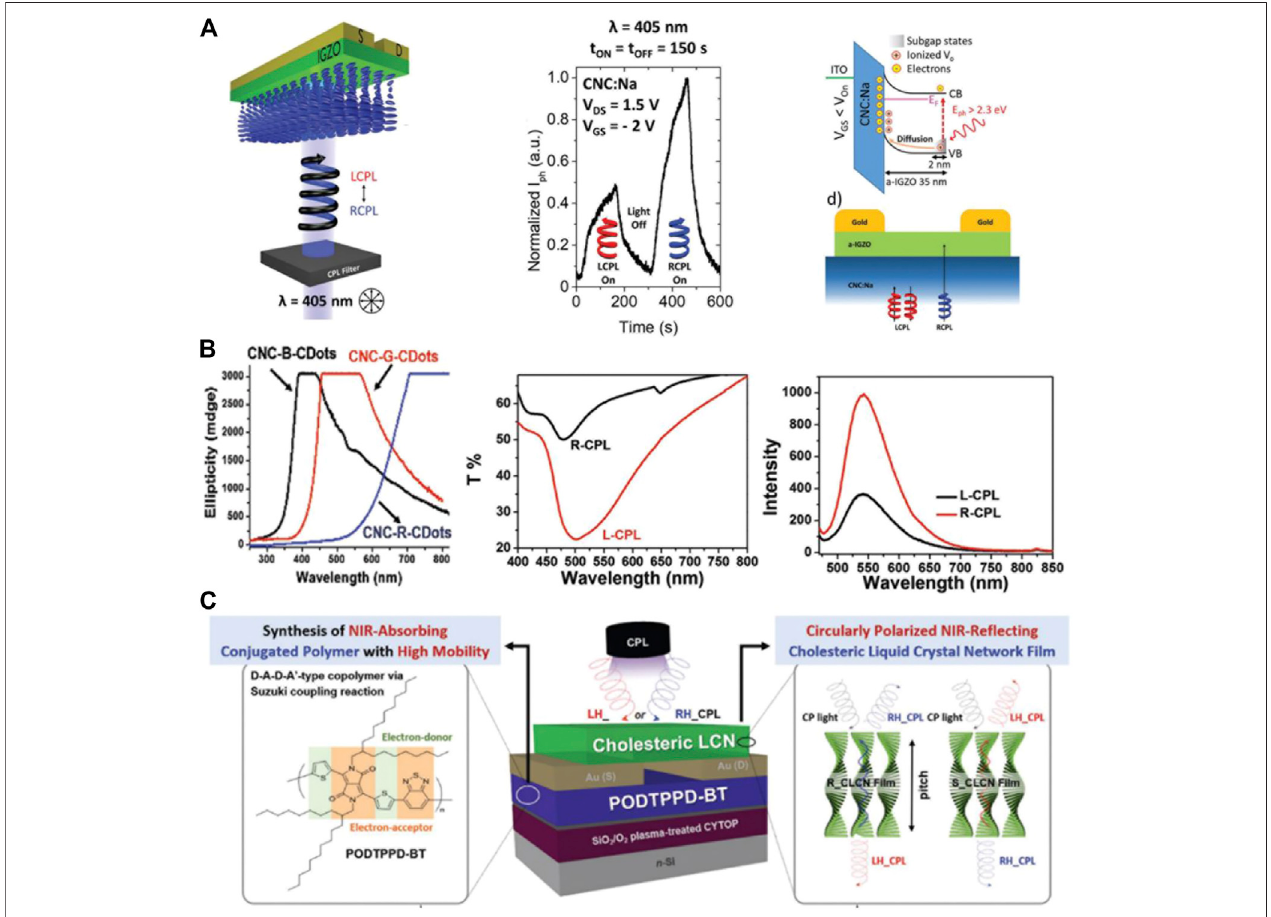
FIGURE 8 | (A) A Schematic representation of the implementation of the CPL detection setup, normalized photogenerated current for 150 s LCPL, 150 s off, and 150 sRCPLcycles,andbanddiagramofITO/CNC:Na/a-IGZO(Greyetal.,2018).Reproducedwithpermission.Copyright2018,Wiley-VCH. (B) CDspectraofCNC-B- C dot fi lms, CNC-G-C dot fi lms, and CNC-R-C dot fi lms. Transmission spectra of a CNC-G-C dot-483 fi lm upon irradiation with LCPL and RCPL and photoemission spectra of a CNC-G-C dot-483 fi lm (Zheng et al., 2018). Reproduced with permission. Copyright 2018, Wiley-VCH. (C) Schematic of the device structure of NIR CPL-OPTRs under circularly polarized NIR illumination and chemical structure of PODTPPD-BT (Han et al., 2020). Reproduced with permission. Copyright 2020, Wiley-VCH.